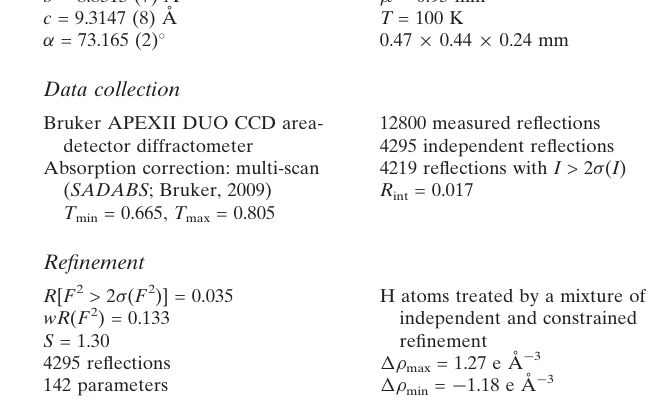
12800 measured reflections 4295 independent reflections